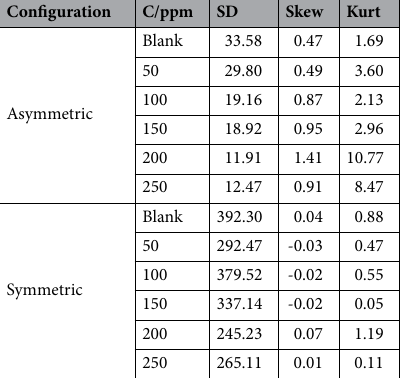
Table 4. Statistical parameters obtained of current signals arising As-Co and Sy-Co made of Al alloy in absent and presence of varies concentrations of RA/AgNPs.